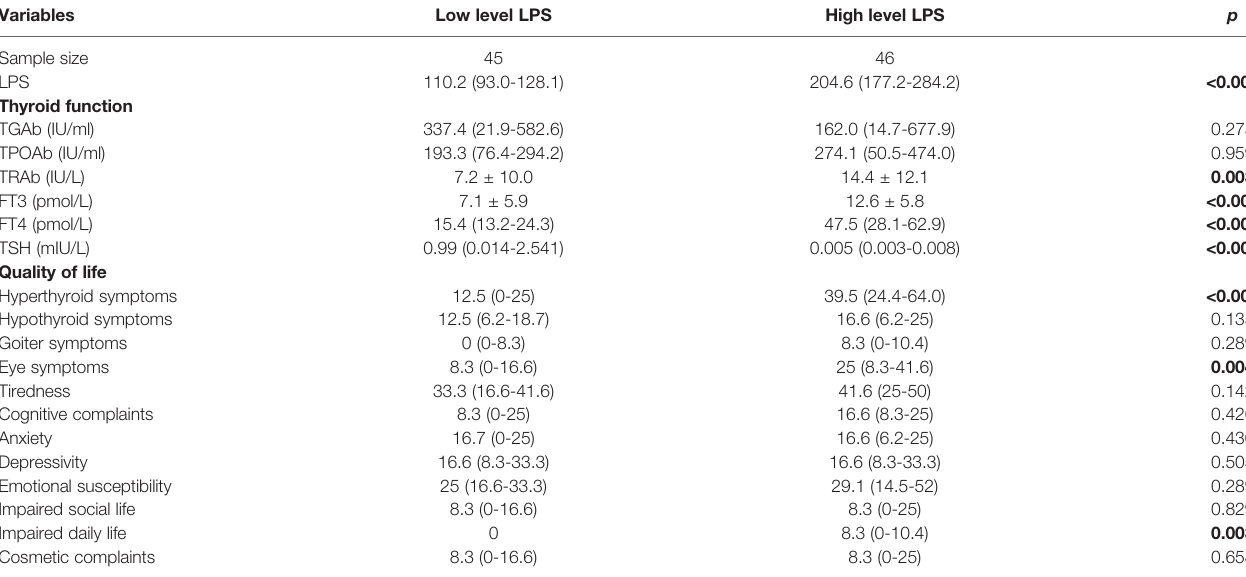
Signi fi cant p values are